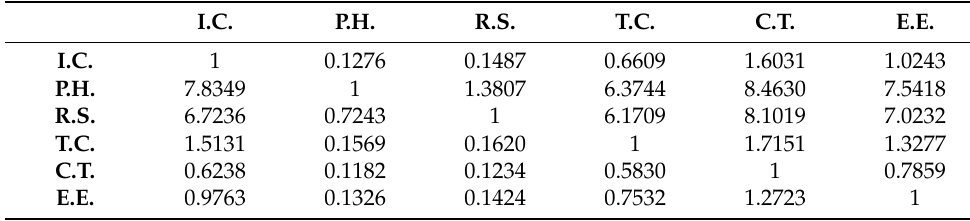
Table 5. Criteria pair-wise comparison